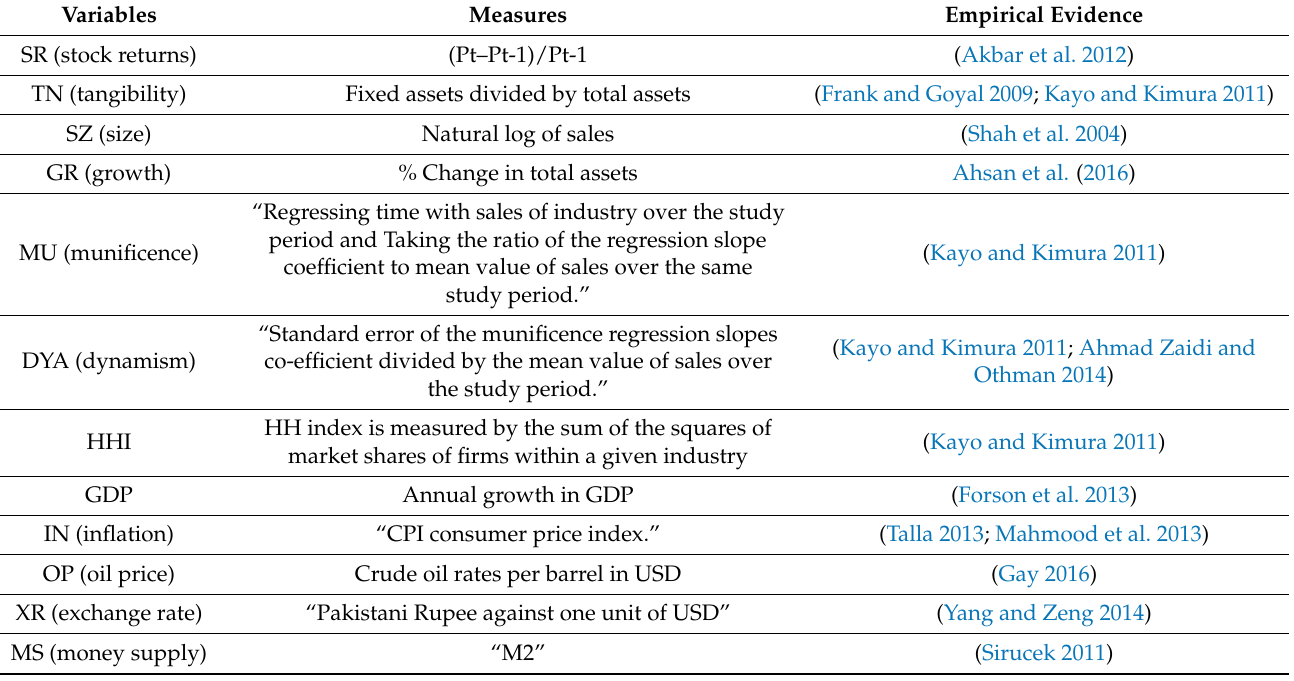
Table 1. Variable